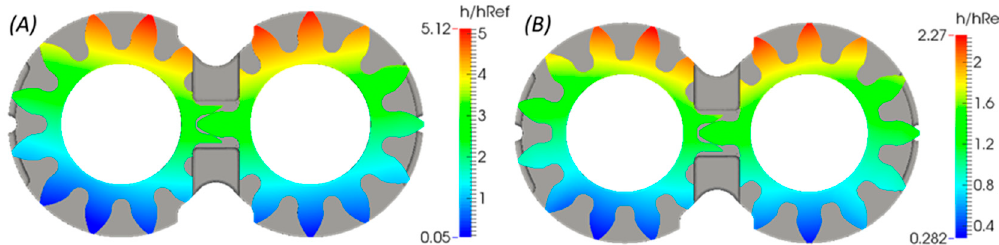
Figure 14. Film thickness distribution in the lateral gap at 500 rpm and p / p ref = 0.72 as predicted by ( A ) Full Film model; ( B ) Mixed Film model.